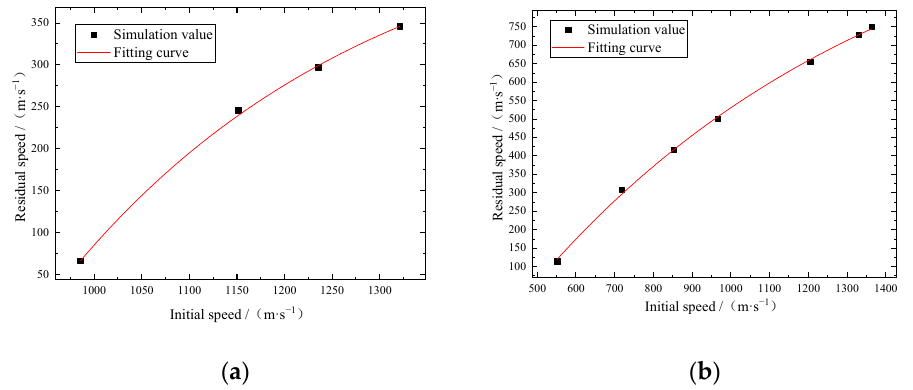
Figure 7. Relationship curve between v 0 and v x obtained by fitting. ( a ) is 6 mm fragment; ( b ) is 11 mm fragment.